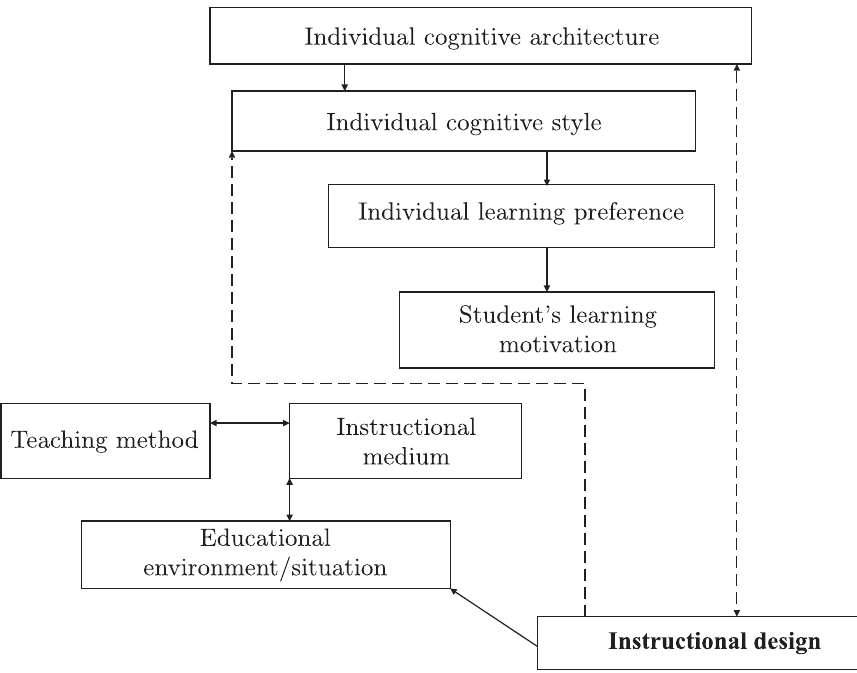
Figure 1. The Instructional Framework of Technology-Based Classroom Tuition of ELP